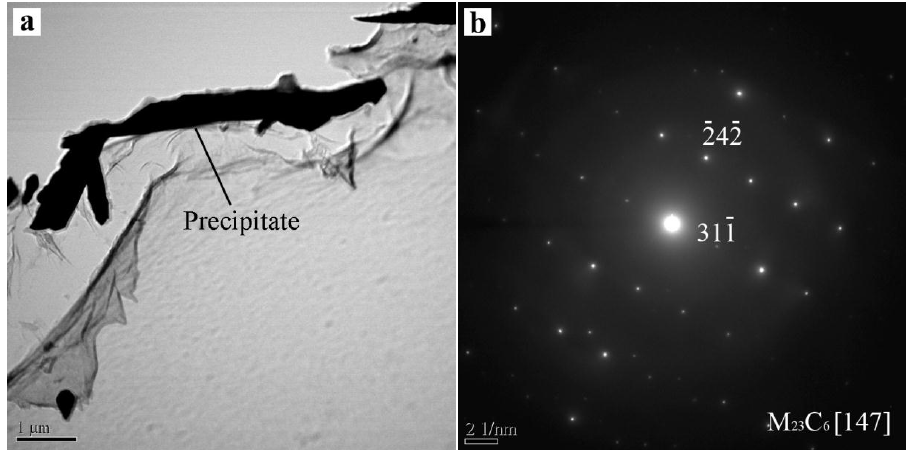
Figure 10. Transmission electron microscopy (TEM) micrograph and the corresponding selected-area electron diffraction (SAED) patterns of the precipitates: ( a ) TEM micrograph of the precipitate; ( b ) the diffraction pattern of M 23 C 6 carbide.